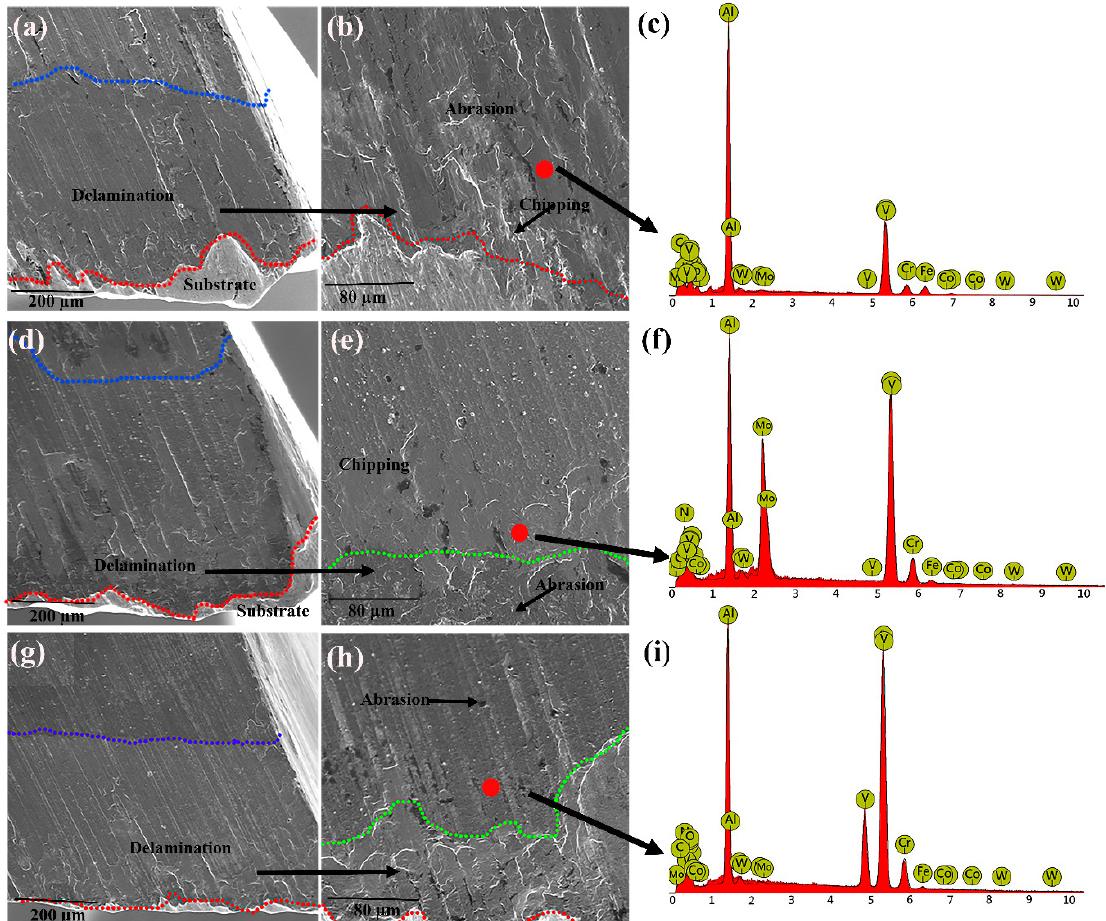
Figure 7. Worn micrographs on flank surfaces of the coated HSS straight shank end milling cutter under the 60 m / min speed: ( a – c ) AlCrN coating; ( d – f ) AlCrMoN coating; ( g – i ) AlCrVN coating.